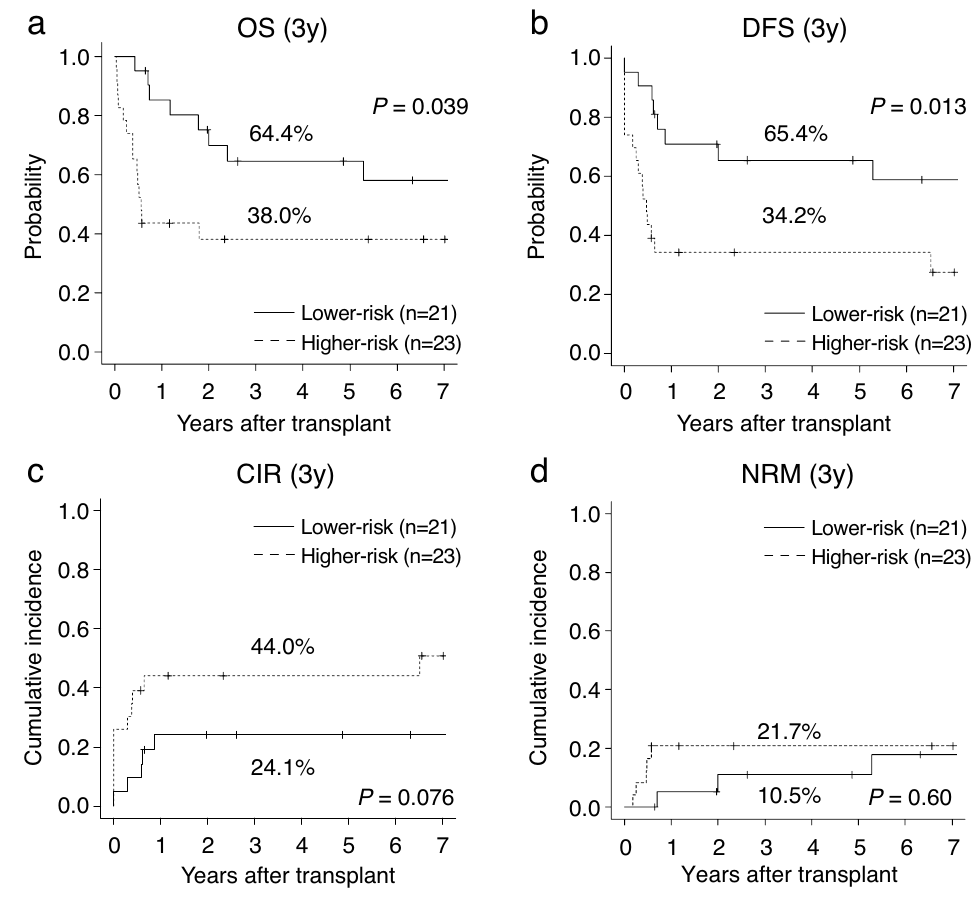
Figure 3. Transplant outcomes of 44 younger patients with MDS. ( a ) overall survival (OS), ( b ) disease-free survival (DFS), ( c ) cumulative incidence of relapse (CIR), and ( d ) non-relapse mortality (NRM) at 3 years after transplant were compared between the patients with higher-risk and lower-risk. CK, complex